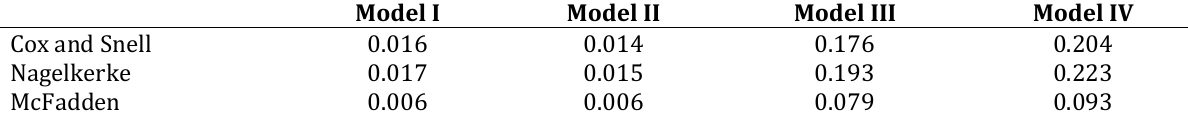
Table 4: Pseudo R- squares of Models I, II, III and IV